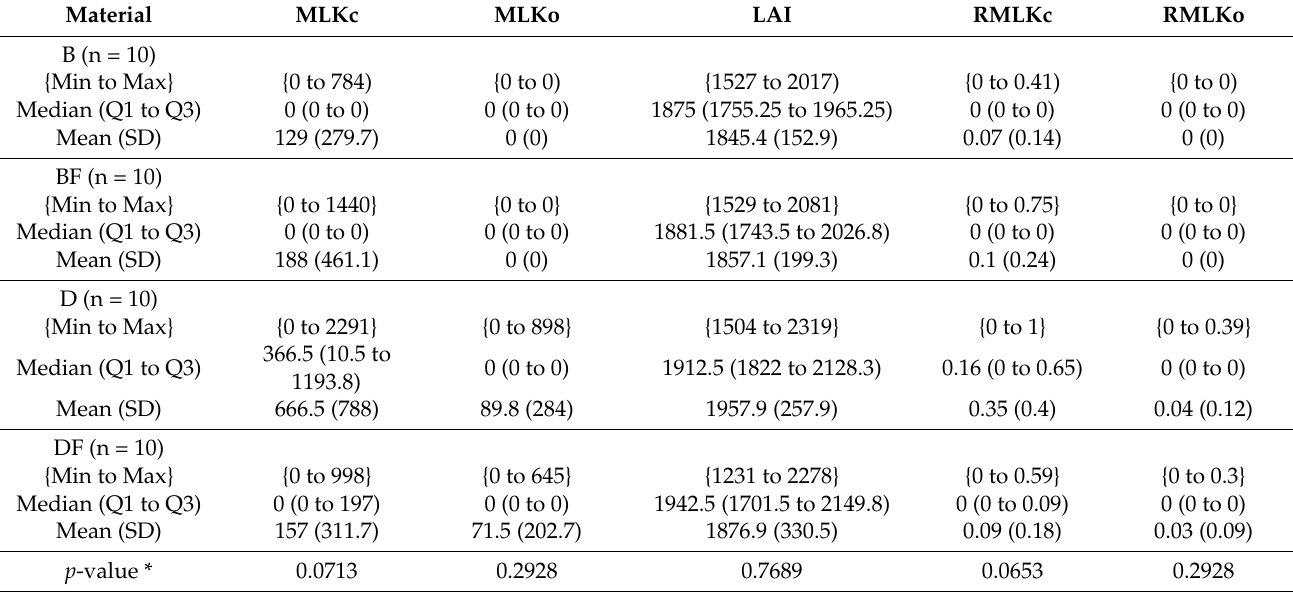
Table 3. Data summary collected for microleakage test based on material type: cementum-located